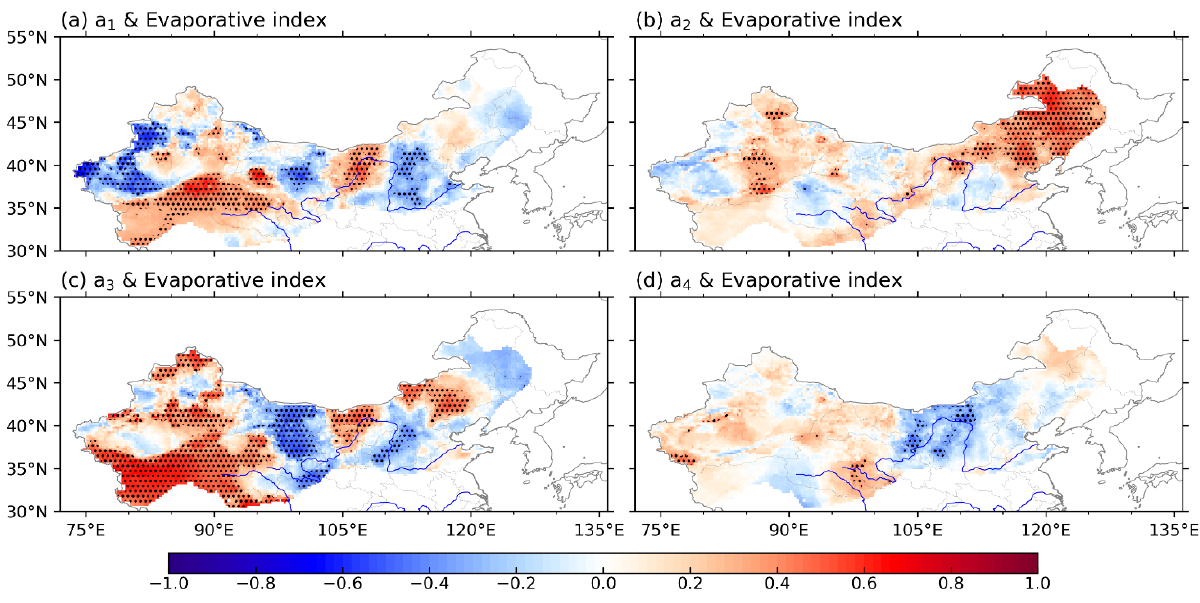
Figure 10 . Same as Figure 9, but for the evaporative index. Figure 10. Same as Figure 9, but for the evaporative